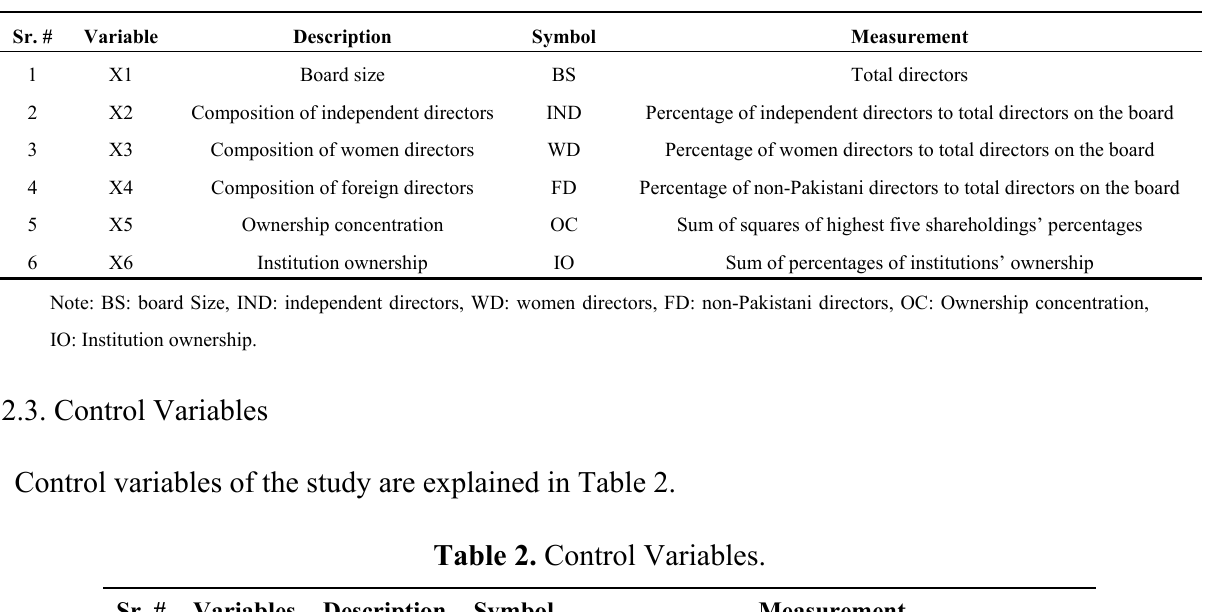
Table 1. Independent Variables.